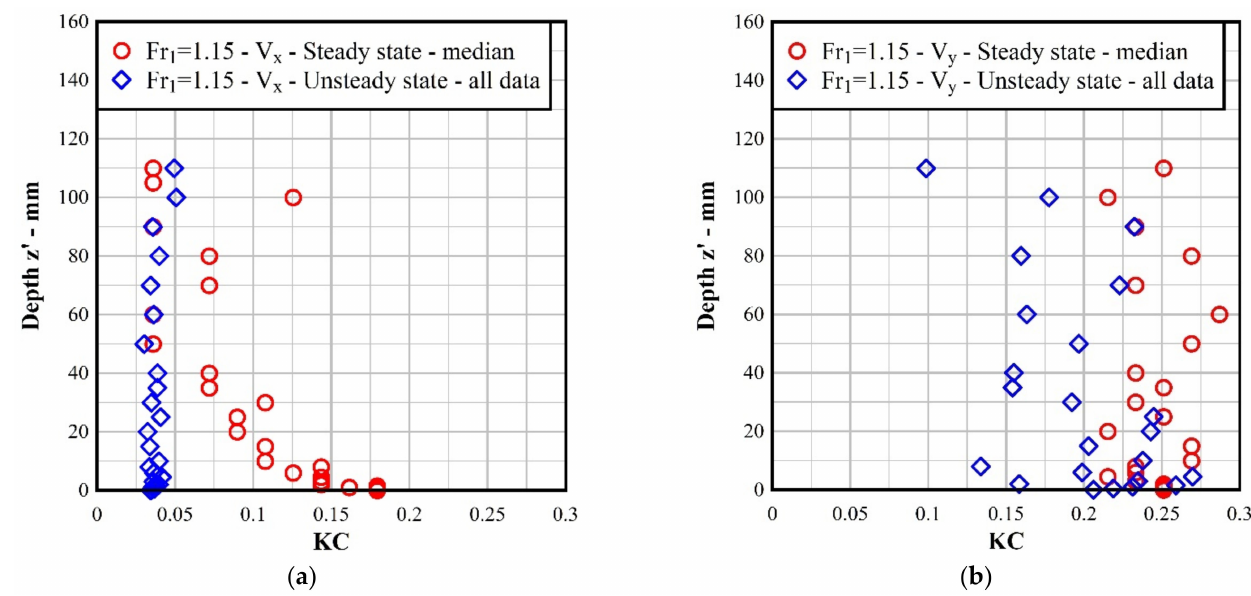
Figure 8. Undular surge, Run 60-7. Kolmogorov complexity vs. vertical elevation z (cid:48) for ( a ) V x ; ( b ) V y